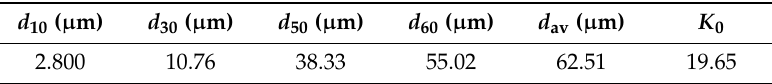
Table 1. The characteristic value of full tailing particle size.